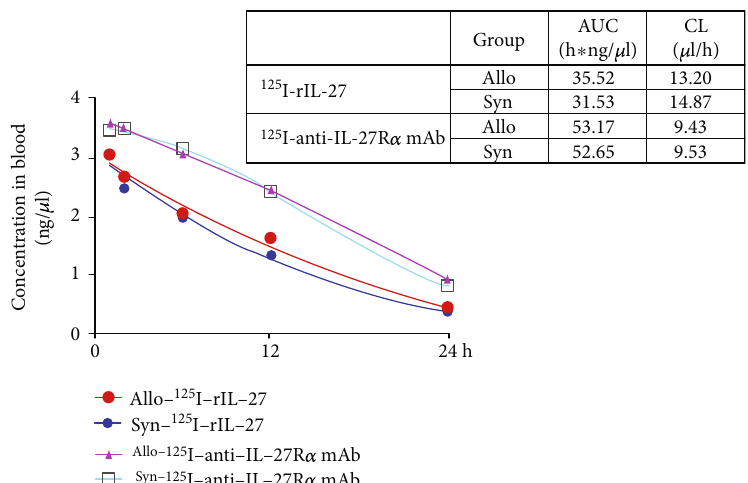
Figure 1: Binding assay of 125I-rIL-27 in vitro.